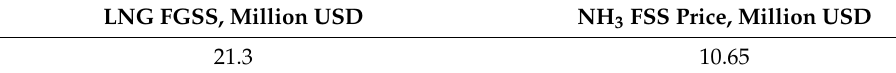
Table 15. CAPEX of LNG FGSS and NH 3 FSS.